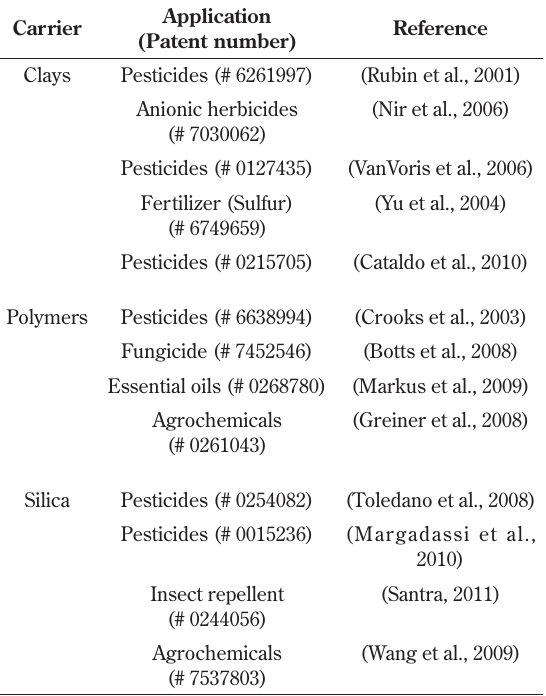
Table 2 Smart delivery systems for agrochemical de- livery – a patent